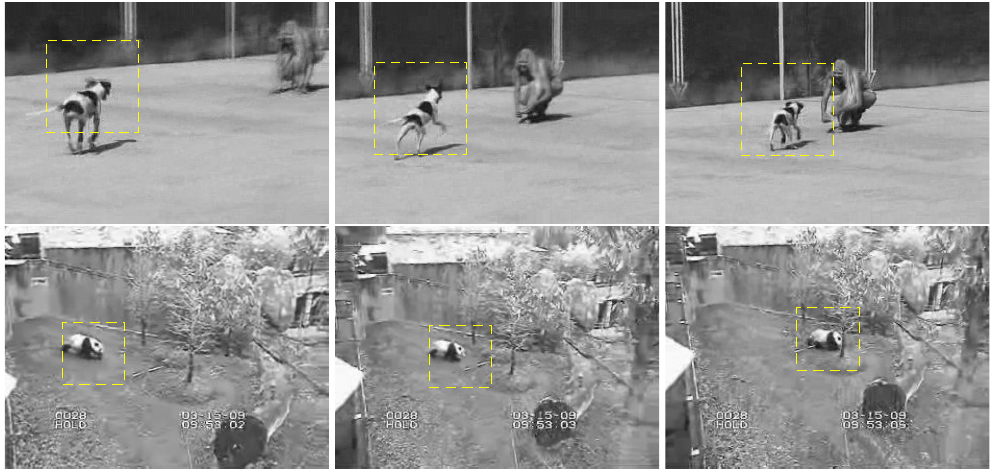
Figure 4. Sample images with marked moving objects in yellow